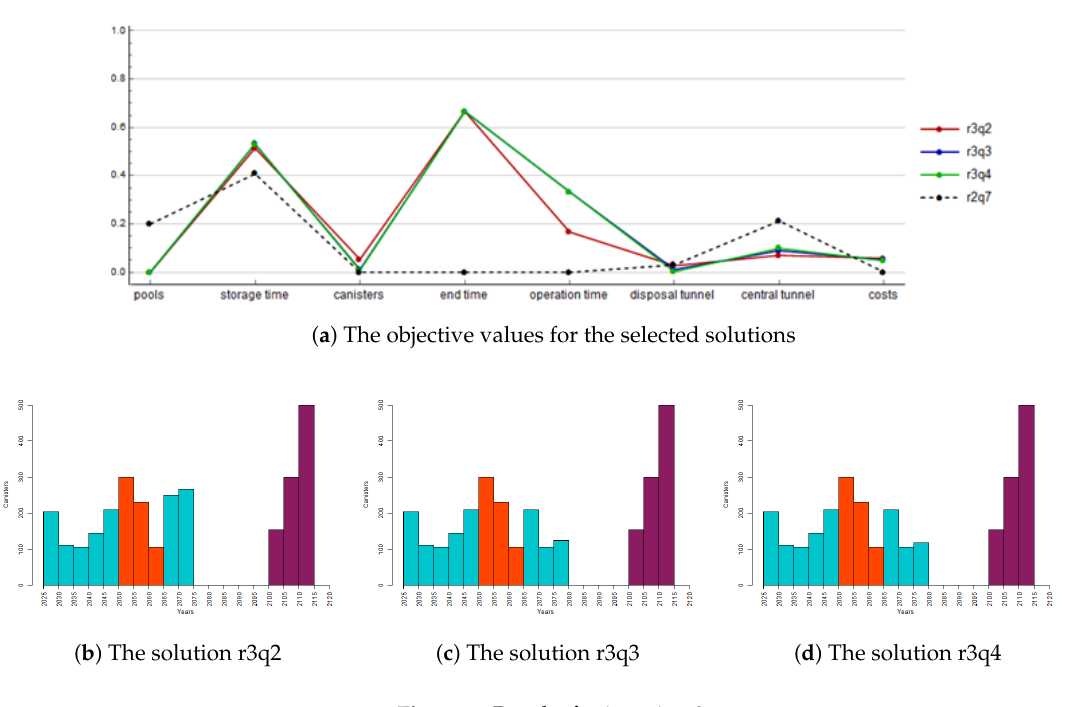
Figure 7. Results for iteration